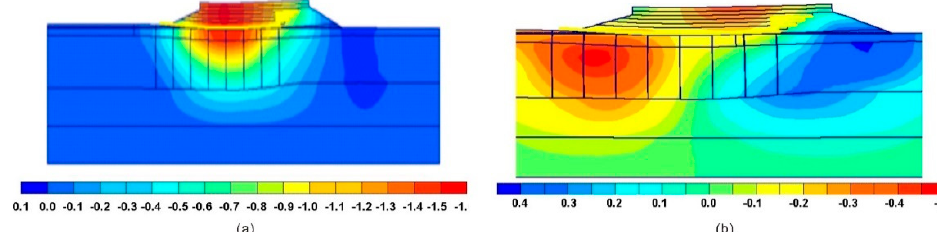
Figure 11. Vertical and horizontal displacement of the equivalent sand-wall model after preloading by 1 year (m): ( a ) vertical displacement; ( b ) horizontal displacement.